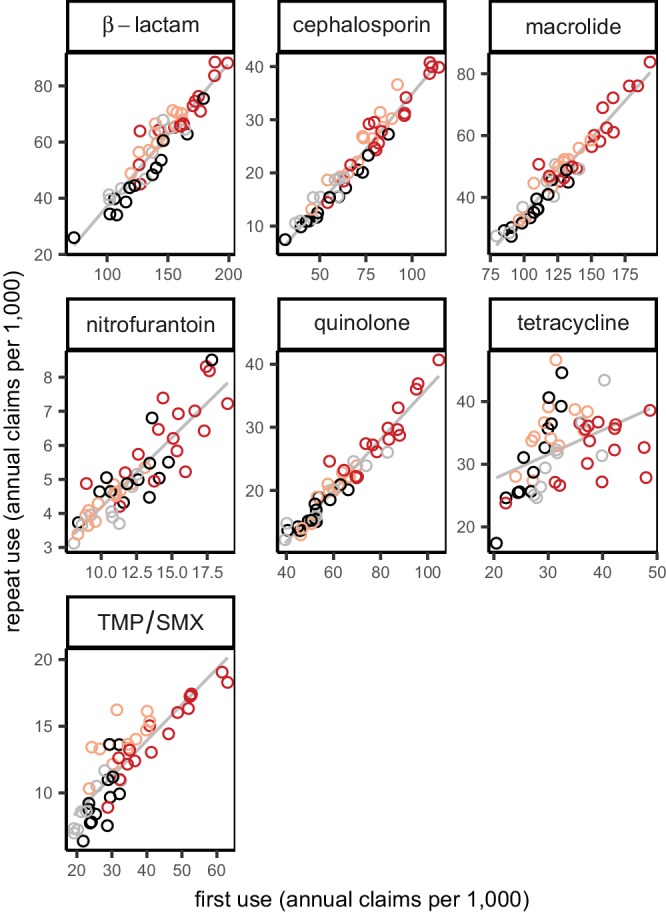
Distribution of antibiotic use by region.Each point shows use for a drug group in a state, averaged over data years. Colors indicate US Census region (red, South; light red, Midwest; gray, Northeast; black, West). Line shows unweighted linear best fit.